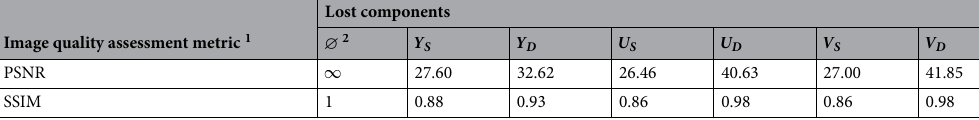
Table 9. The quality of the reconstructed image when exponential noise is added to a component. The 1 experimental results are obtained on the DRIVE dataset. The difference evaluation between the reconstructed 2 image and the original image. It means no loss of components.